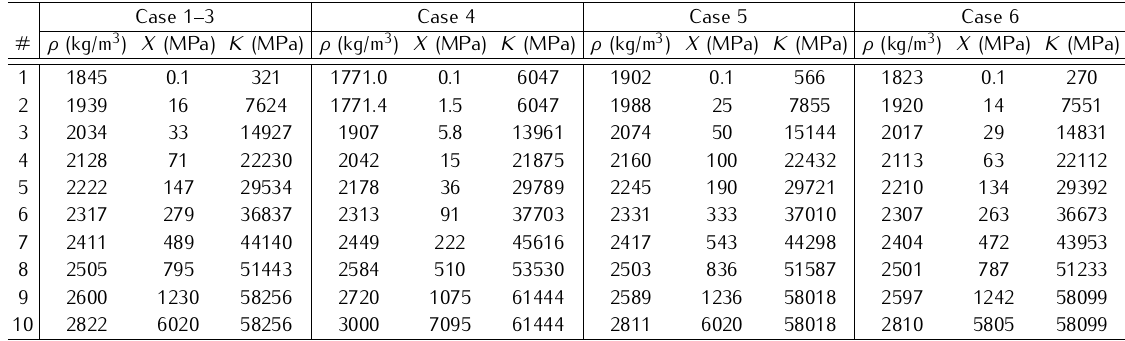
Table 8. Tabulated input data for soil, corresponding to the simulation cases.